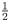
Increasing vector mortality can elevate pre-sensitised and total infection cases when pre-exposure to vector saliva prolongs the time to recovery.Shown are (a) the abundance of infectious vectors, (b) naïve infected hosts, and (c) pre-sensitised infected hosts in the ODE model. The total infection cases in the host population (the sum of b and c) can increase with vector mortality, since pre-sensitised infections are more abundant (note the difference in scale between b and c). The dashed grey line shows the result when pre-exposure has no effect (i.e. γH′ = γH). Shown in cool colours are the results when pre-sensitisation causes decreased recovery rates with the strength of pre-sensitisation reflected in the intensity of blue: recovery rates of pre-sensitised infected hosts equaling 12, 13, and 15
th of the recovery rate of naïve infected hosts. Conversely, the effects of pre-exposure as increased recovery rate are shown in warm colours reflecting 2, 3, and 5 times the recovery rate of naïve infected hosts.